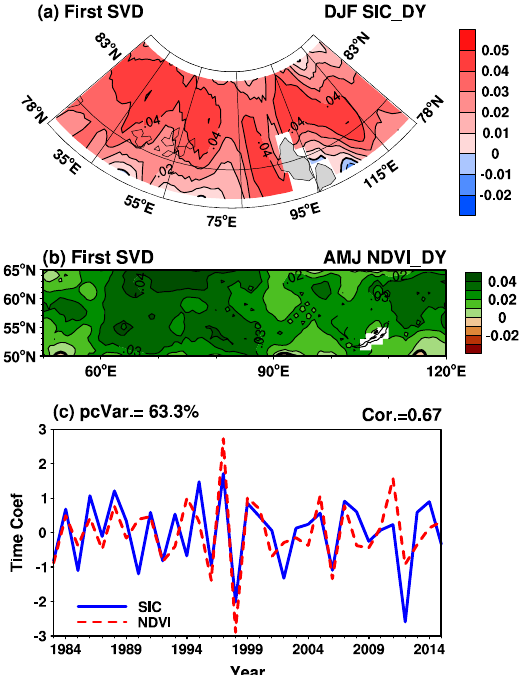
Figure 4. Spatial patterns for the first paired mode of the DY of ( a ) winter (December–January–February (DJF)) sea-ice cover over the Barents Sea (SICBS) and ( b ) spring (April–May–June (AMJ)) NDVIEA via SVD analysis during 1983–2015. ( c ) The corresponding normalized time series of the expansion coe ffi cients for the paired mode; their correlation coe ffi cient is shown above the top right-hand corner, and the variance explained by the first mode is shown above the top left-hand